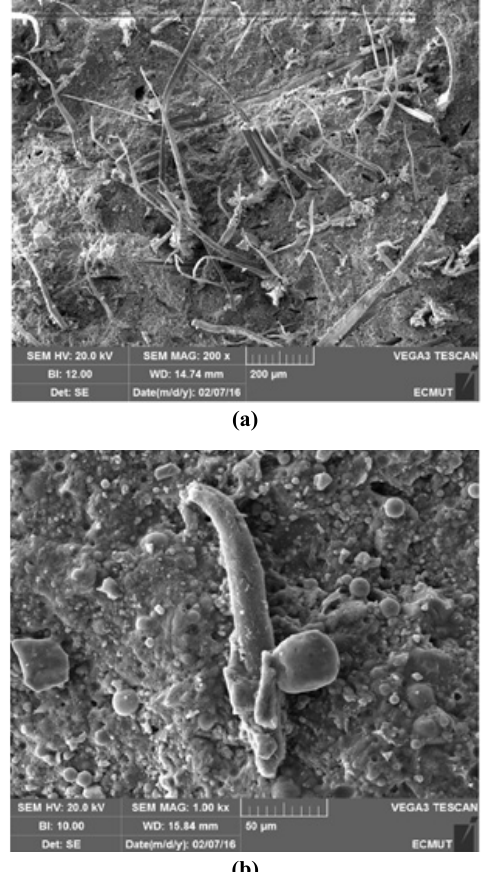
Fig. 6 SEM image of cement composites containing (a) CP and (b) CMF.